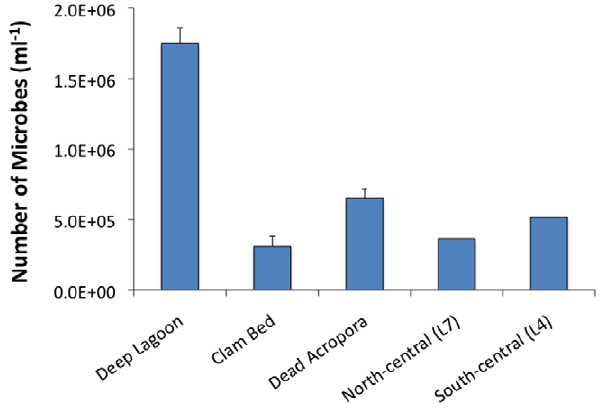
Figure 5. Abundance of microbes within the lagoon. The sites included a deep pool in the central lagoon (n=4), directly above a clam bed (n=2), directly above a dead Acropora stand (n=2), south-central lagoon L4 (n=1), and north-central lagoon L7 (n=1). Error bars depict standard error.